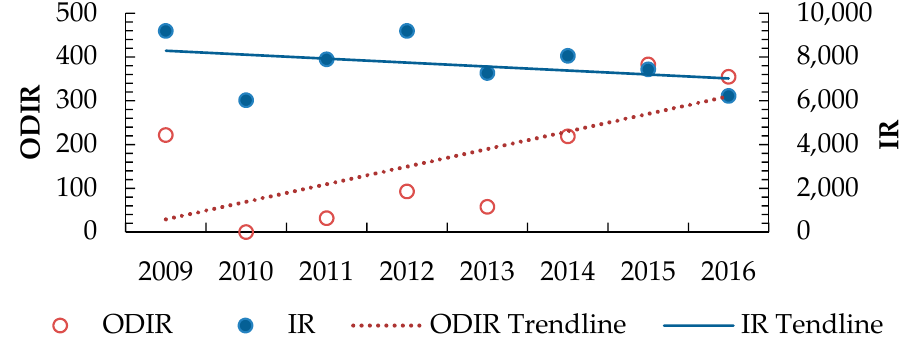
Figure 13. ODIR and IR of the industrial sectors during 2009–2016. Where ODIR = Number of workplace diseases of the total number of employees per 100,000 employed persons, IR = Number of workplace injuries of the total number of employees per 100,000 employed persons.